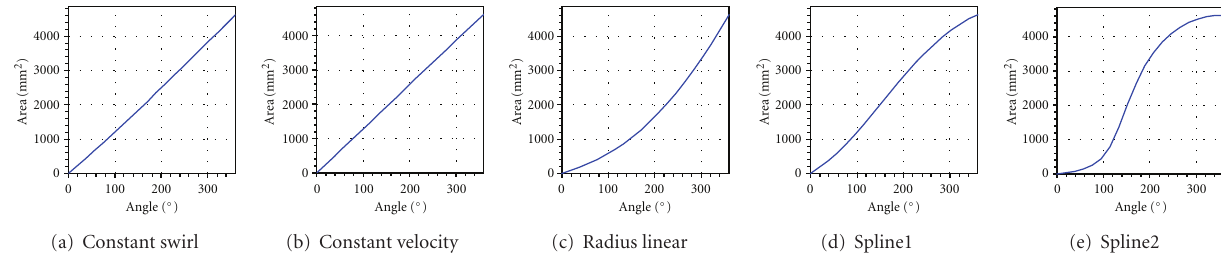
Figure 7: Di ff erent design rules of spiral development areas.